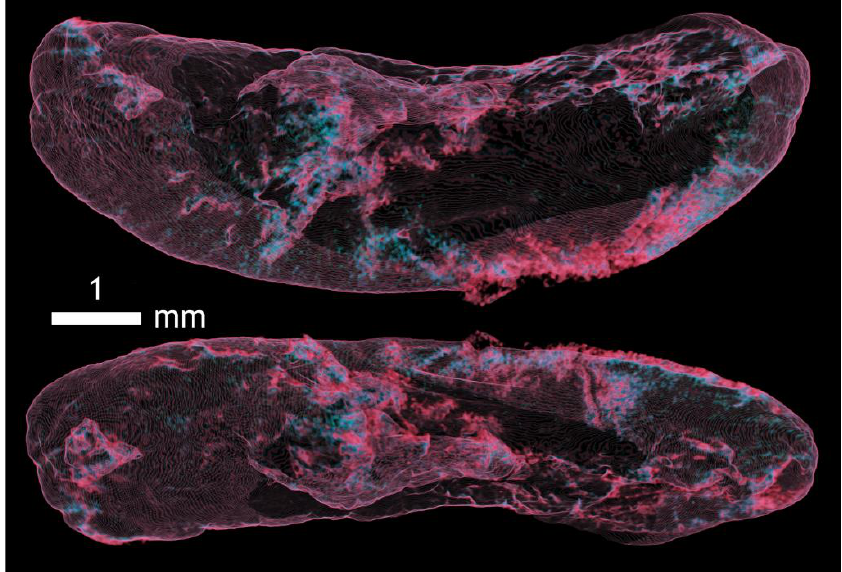
Figure A10. Imaging of the capsule of the spleen and superficial vessels in fascial tissue in two positions using Omnipaque contrast.